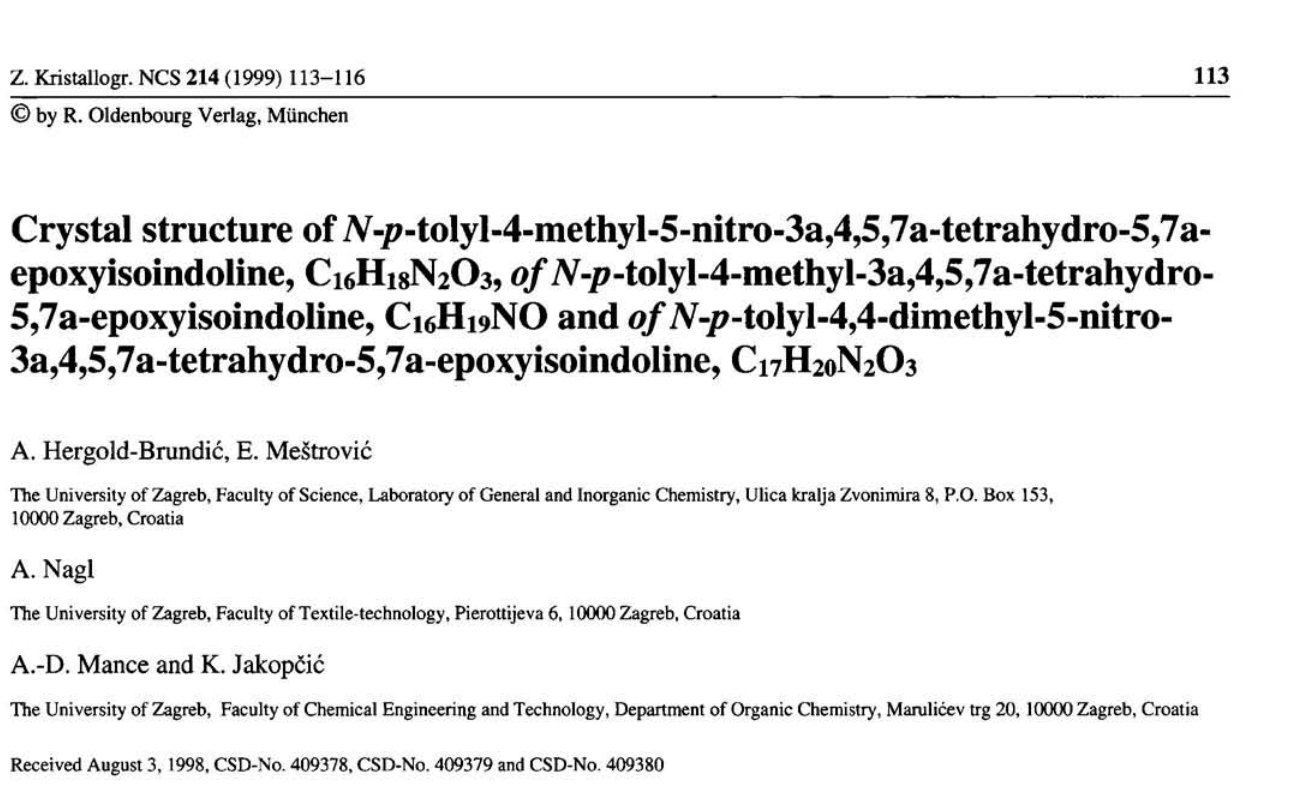
Table 1. Data collection and handling.